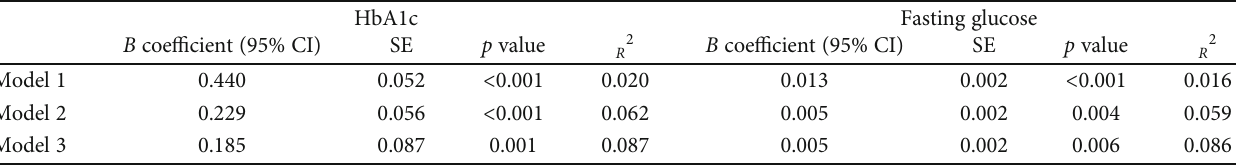
β coe ffi cients are estimated values in mg/dL re fl ecting the complex sample weight. Model 1 on both categories is the unadjusted model. Model 2 is adjusted by age, gender, mean SBP, triglycerides, sedentary hours a day, binge drinking frequency, waist circumference, and smoking state. Model 3 is added by adjusting WBC in Model 2. SE: standard error. Table 3: Complex samples of general linear model for HbA1c and hs-CRP in males and females.